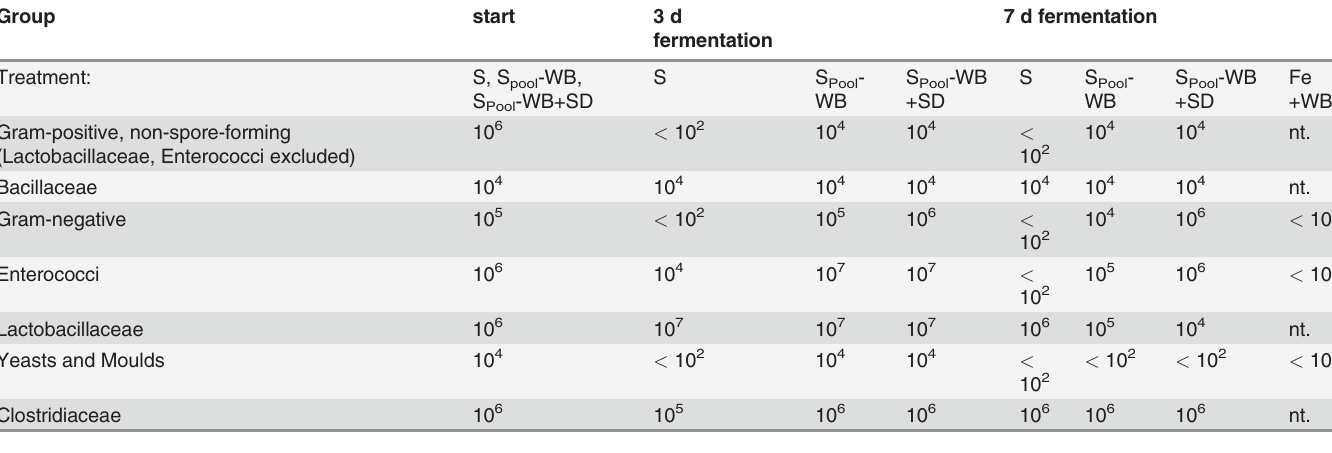
Table 4. Community shifts within treatments S, S Pool -WB, S Pool -WB+SD, Fe+WB. Group start 3 d